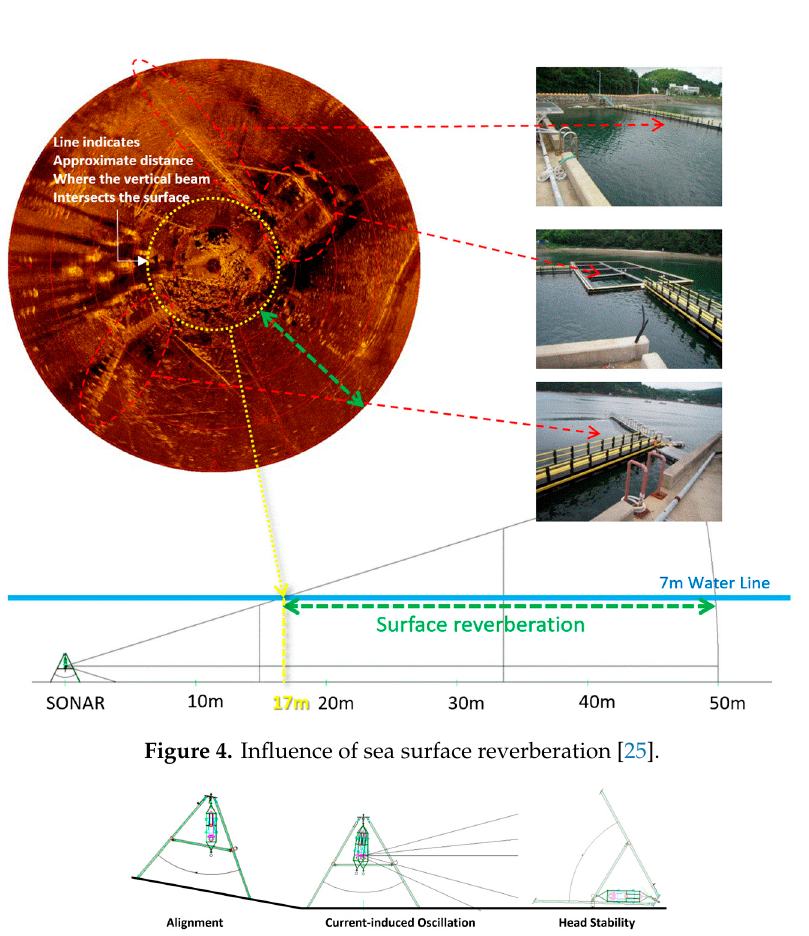
Figure 5. Disadvantages of the tripod with a gimbal in a strong current.